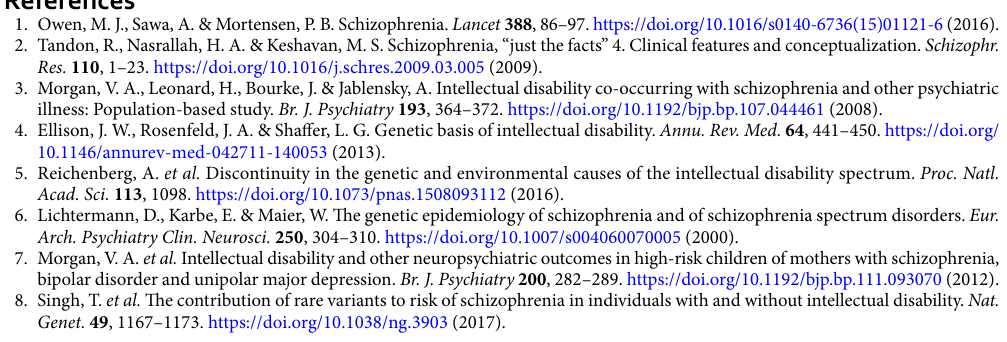
Schematic diagrams. The schematic of NPAS3 and NPAS4 variants analysed (Fig. 1) and the schematic of the reporter gene construct (Fig. 2a) were created using the IBS software 67